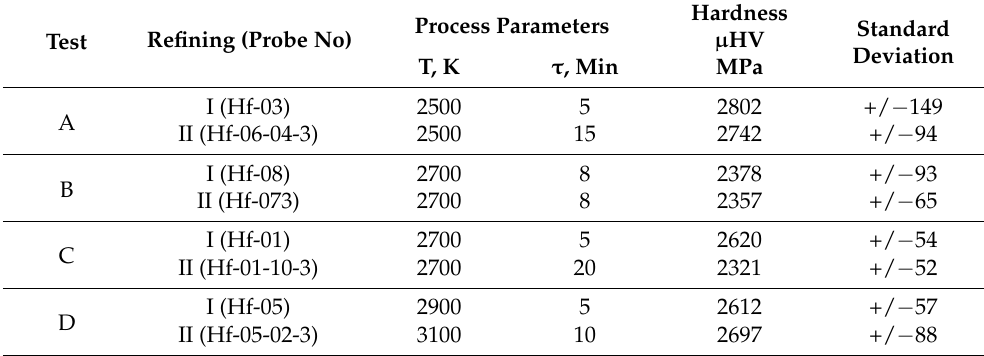
Table 5. Average micro-hardness and standard deviation measured for hafnium specimens produced after double e-beam melting and